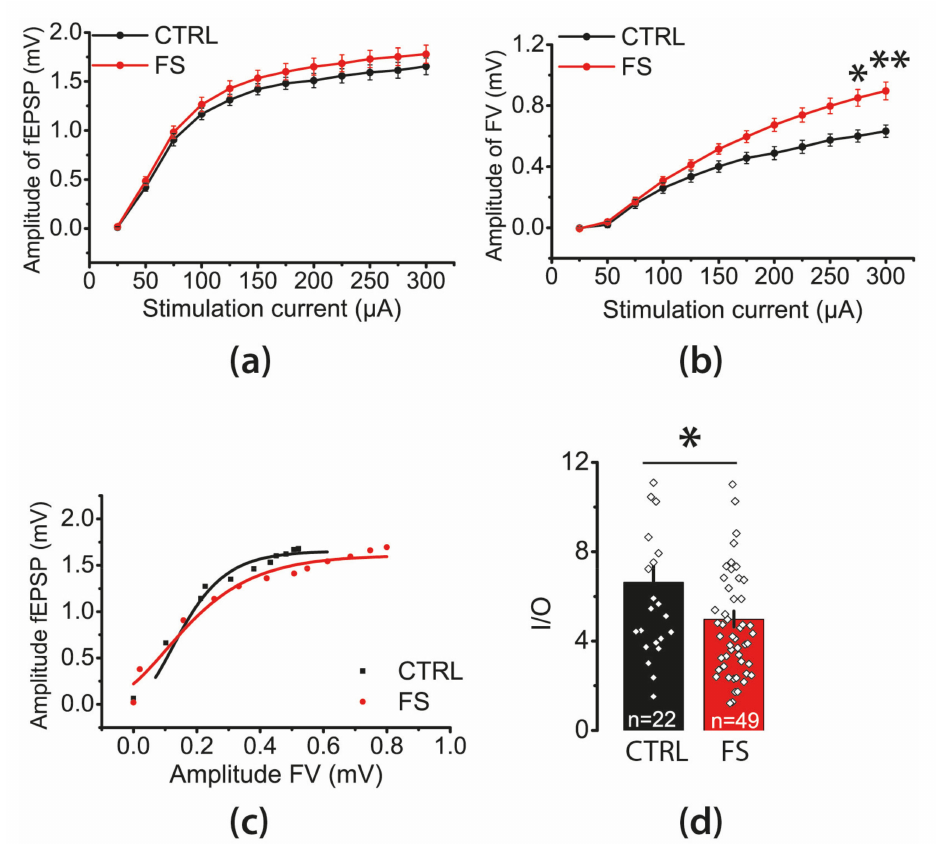
Figure 2. Stimulation–response relationships for fEPSP amplitudes ( a ) and presynaptic FV amplitudes ( b ) recorded from the hippocampal CA1 area in control (CTRL) and FS rats. Each point represents the mean ± SEM. ( c ) Representative examples of I/O relationships between the fEPSP and FV amplitudes in hippocampal slices of control and FS rats. ( d ) The maximal I/O slopes were smaller in FS rats than in control animals. Each rhombus represents a value obtained in individual brain slice. One to three slices were used per animal. * p < 0.05, ** p < 0.01—the difference between control and FS